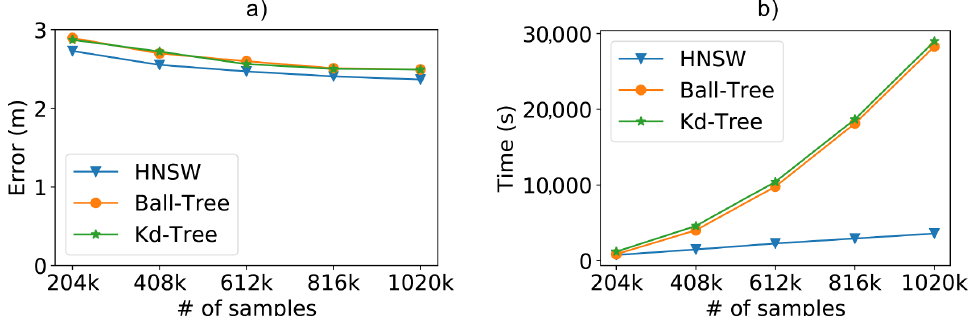
Figure 11. ( a ) Positioning error and ( b ) total time (fitting + classification) when using the real-world SmartCampus dataset and increasing the number of samples with K = 3.